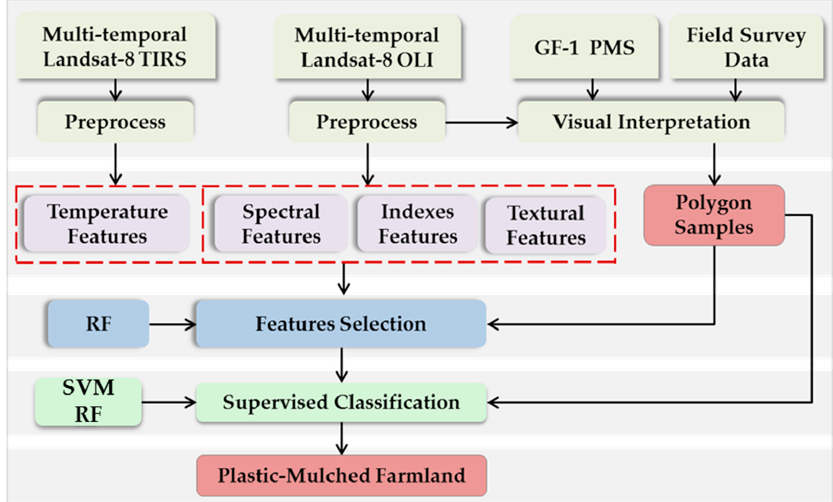
Figure 3. Work flow of this paper. GF-1: GaoFen-1, Chinese satellite; RF: random forest; SVM: